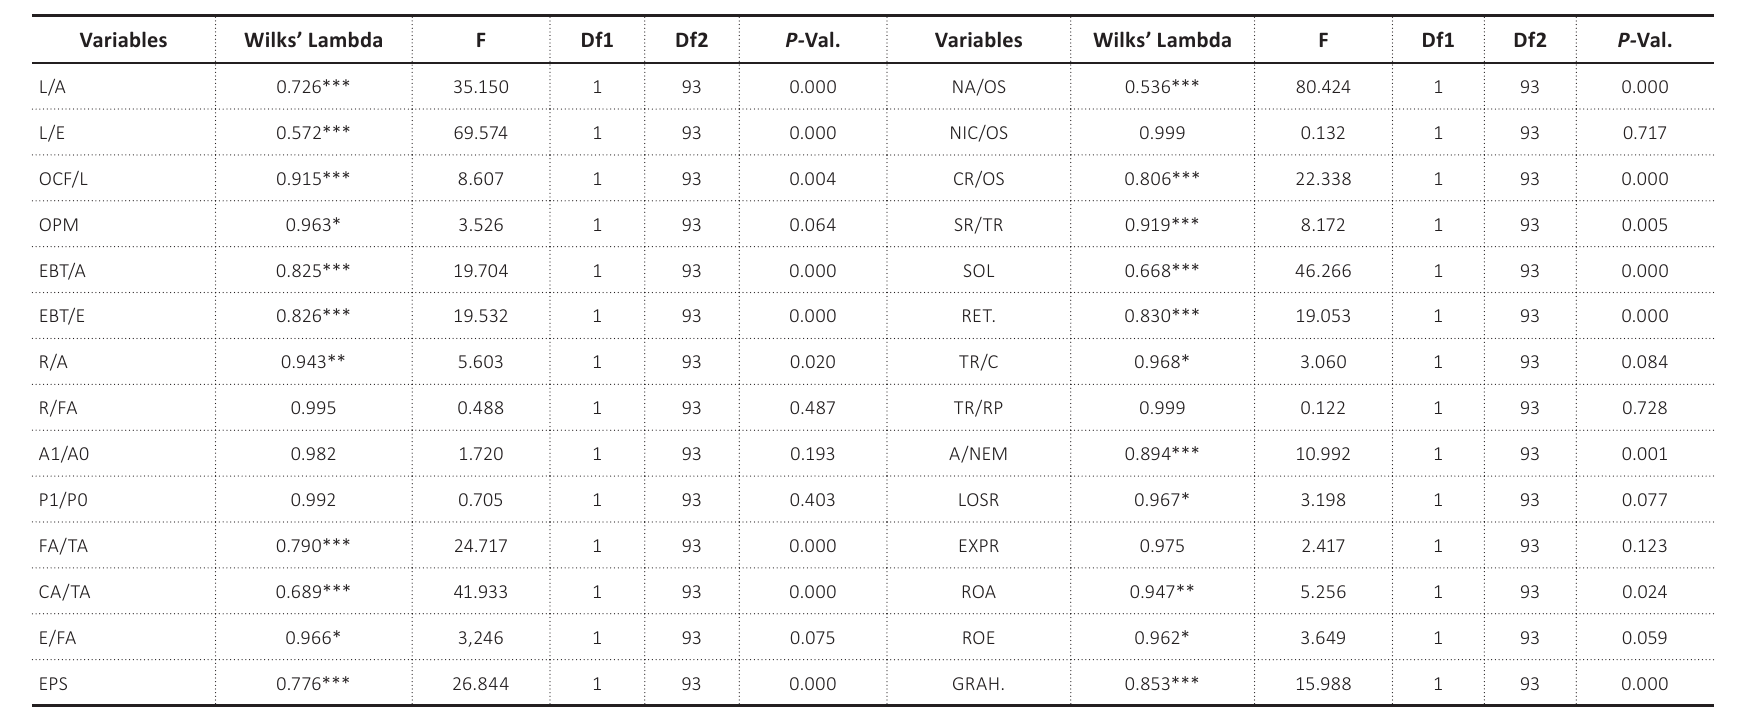
Table 2. Equality of group